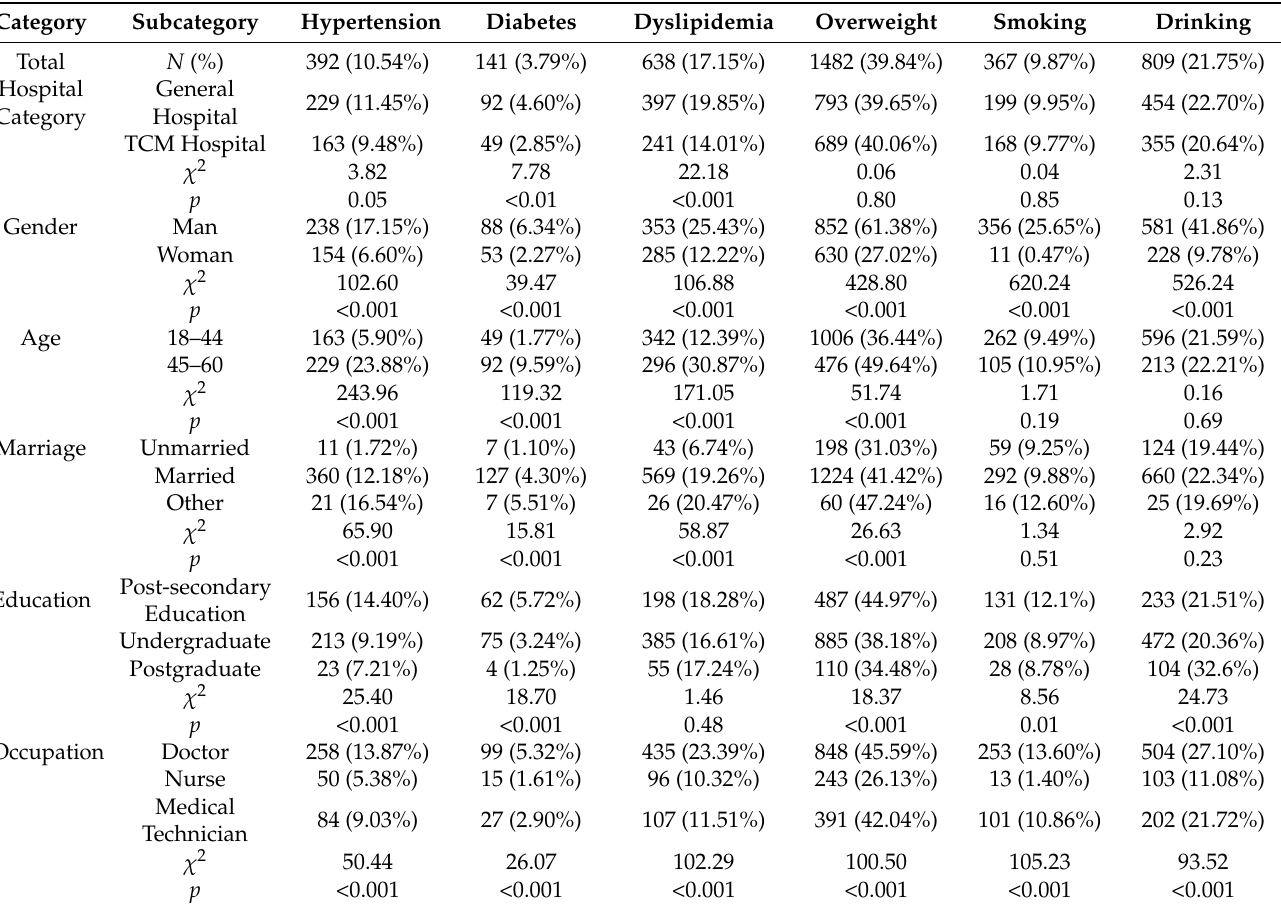
Table 2. The prevalence of CVD risk factors by relevant